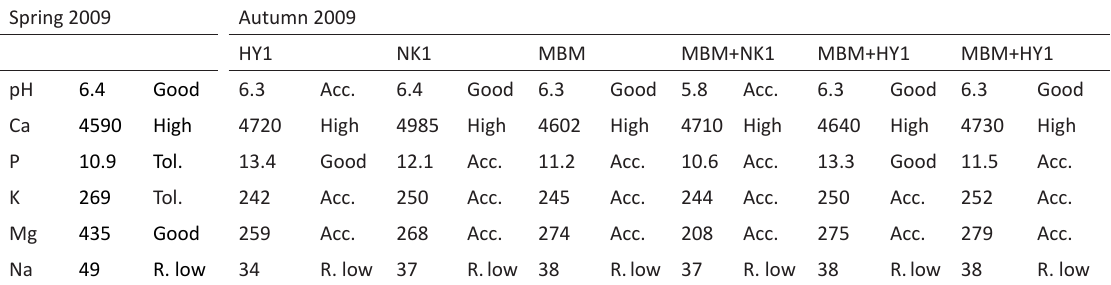
Table 2. Soil analysis results from before sowing and after harvest of sugar beet in 2009 (mg l -1 , except pH) Spring 2009